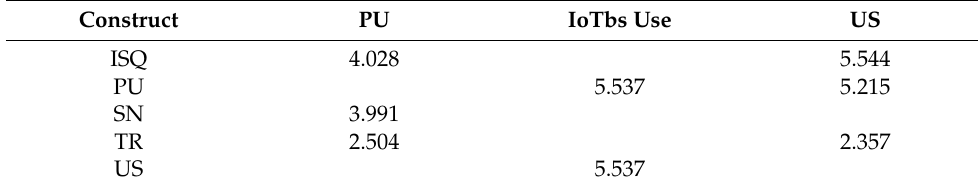
Table 5. Collinearity analysis result.